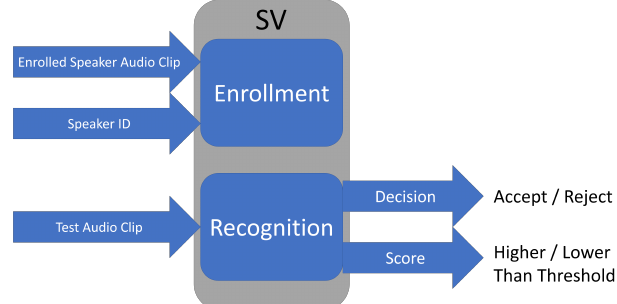
Figure 1. A score-based speaker verification